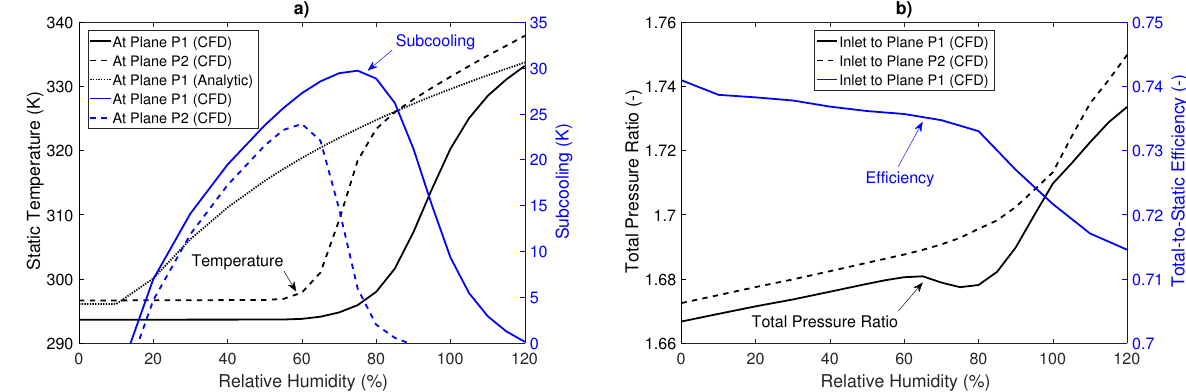
Figure 4. Turbine performance in dependence of the relative humidity at the stator inlet. ( a ) Static temperature and subcooling. ( b ) Total pressure ratio and